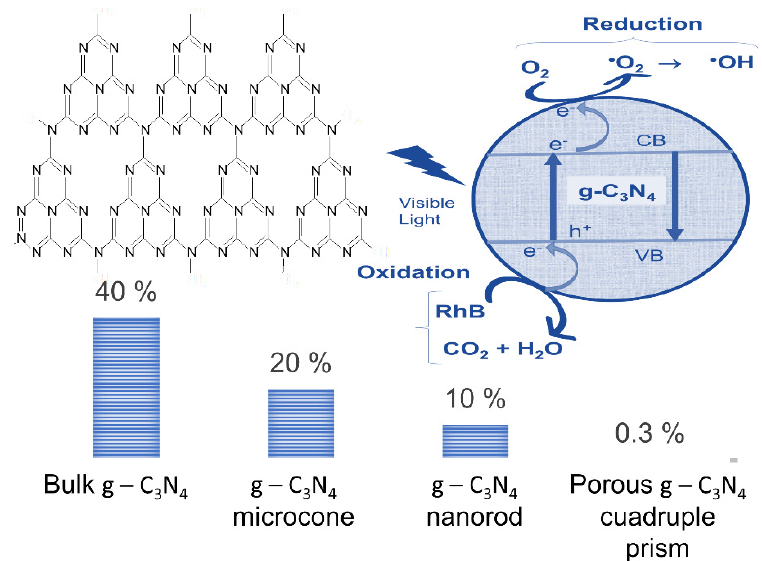
Figure 8. Photocatalytic activity of g- C 3 N under visible light with five different morphologies after 120 min of treatment [90]. Adapted with permission from Elsevier, Materials Science in Semiconductor Processing, Effect of morphology on the photocatalytic activity of g-C 3 N 4 photocatalysts under visi- ble-light irradiation, Xingtong W. et al., License Number: 5391770315356, 2015.